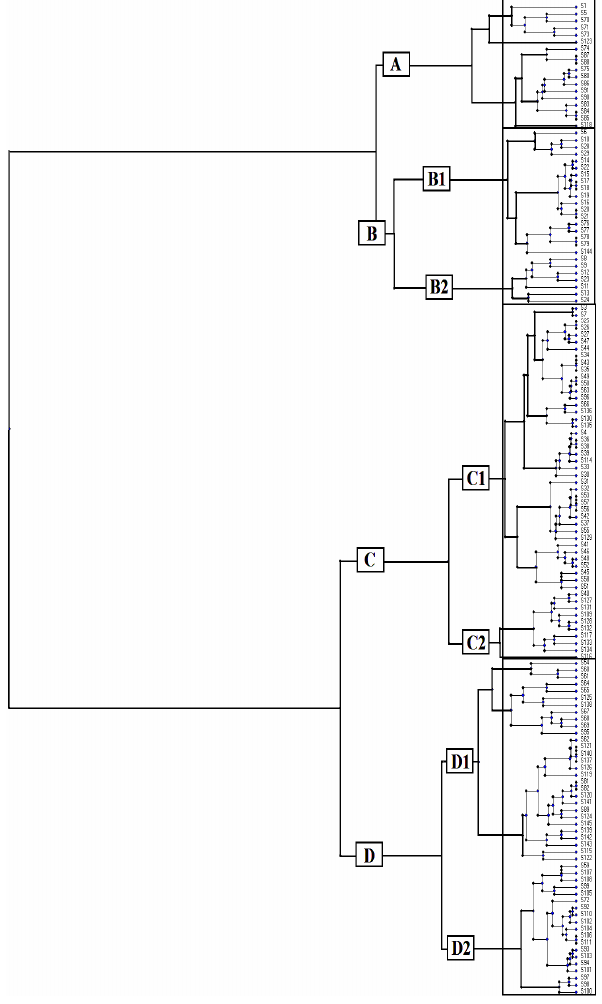
Fig. 3. Dendrogram showing cluster analysis of the studied 142 stands, with the 7 vegetation groups (A-D2)